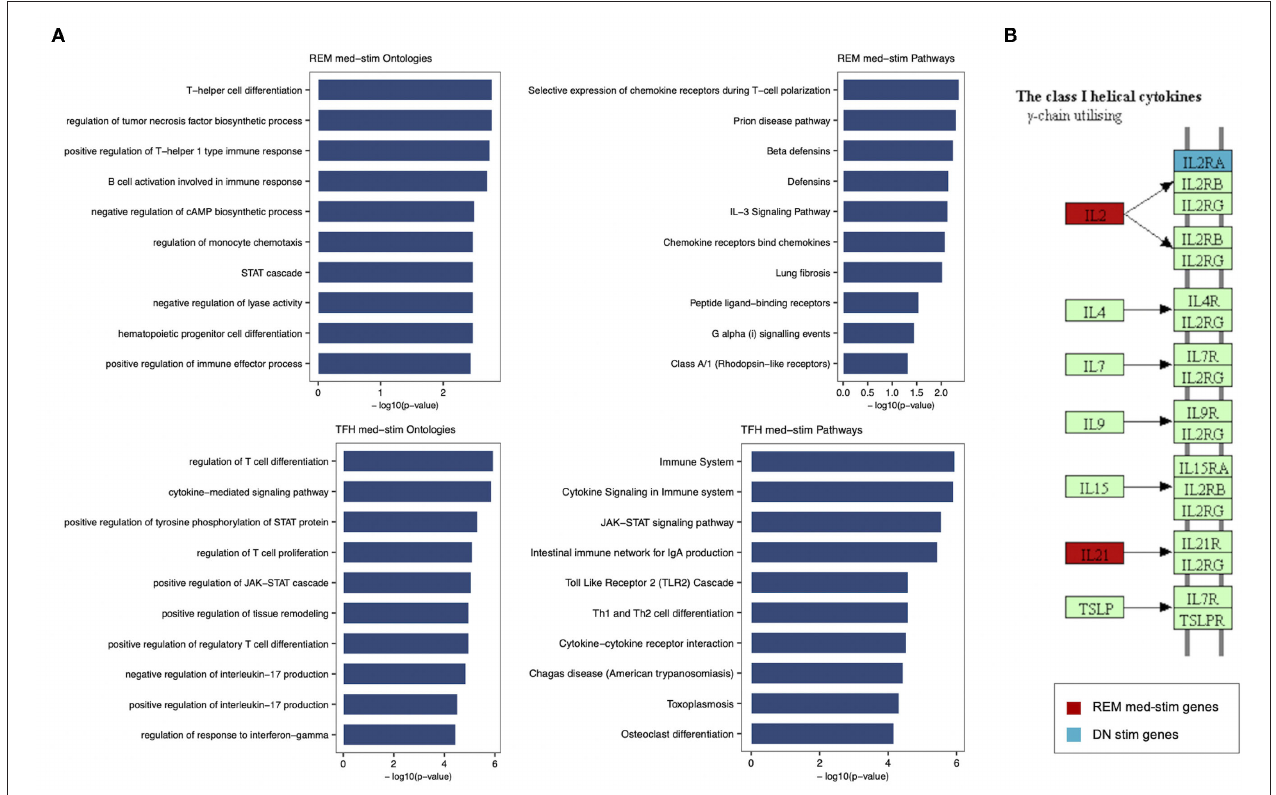
FIGURE 5 | Enrichment analysis performed for REM med-stim and TFH med-stim genes on GO terms and pathways. (A) Bar plots with the top 10 terms sorted by p -value. (B) Cytokine-cytokine receptor Kegg map that shows in red the REM med-stim genes and in blue the DN stim